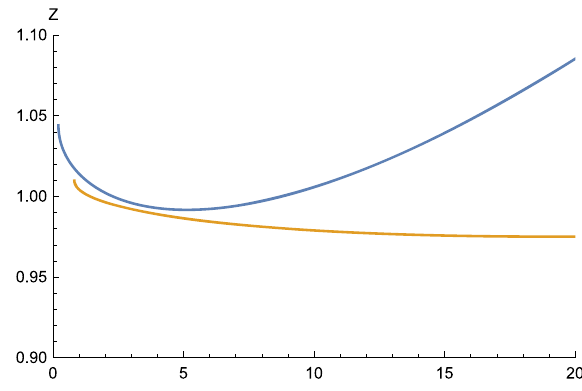
Fig. 1 Dependence of the residue Z for the Higgs field propagator on the gauge parameter ξ , for Region I (blue), and Region II (orange) = λv 2 , so that m 2 = 0 . 23 μ 2 and m 2 m 2 h Region I and m 2 = 0 . 625 μ 2 and m 2